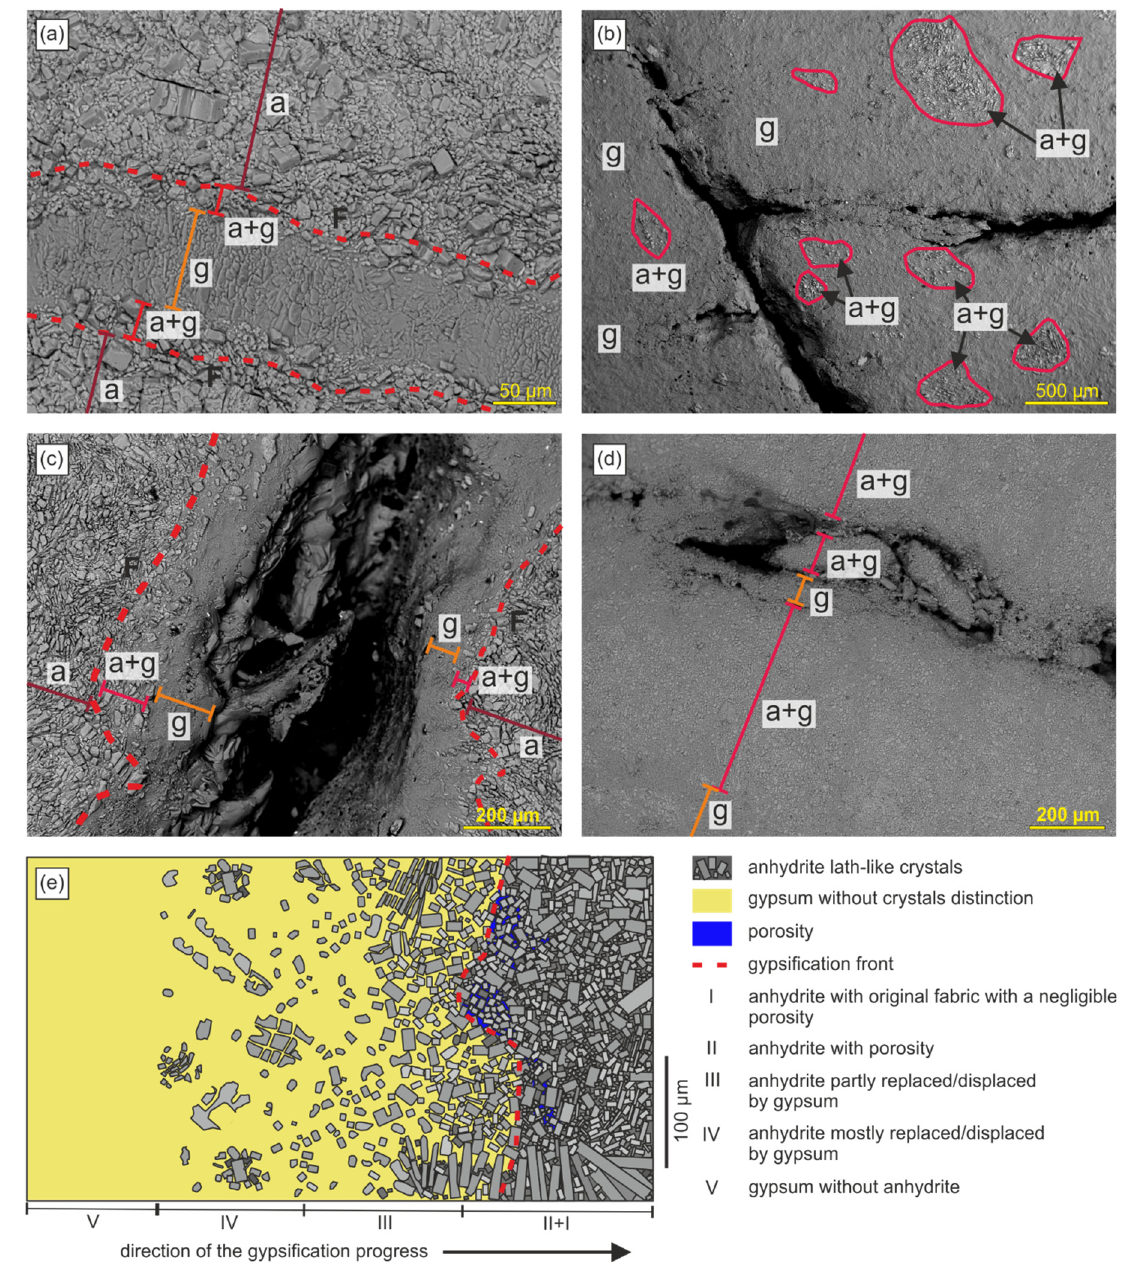
Figure 8. Microscale gypsification zones in gypsum-anhydrite rocks seen in the SEM images; g and orange line–zone composed of gypsum; a + g and light red line–zone composed of anhydrite and gypsum; a and dark red line–anhydrite; F and light red dotted line–gypsification front. ( a )–gypsum vein surrounded by thin zones of gypsum and anhydrite, which contact with massive and slightly porous anhydrite along the gypsification front; ( b )–gypsification zone around semi-closed fractures showing T-shaped junction, composed of gypsum and relics gypsum-anhydrite islets; note en-echelon pattern of fractures near the letter b; ( c )–narrow gypsification zones of anhydrite developed around fracture; ( d )–vast gypsification zones around fractures; ( e )–the model of the structure of gypsification zones developed near the advancing gypsification front; for the sake of simplicity the fractures are omitted.